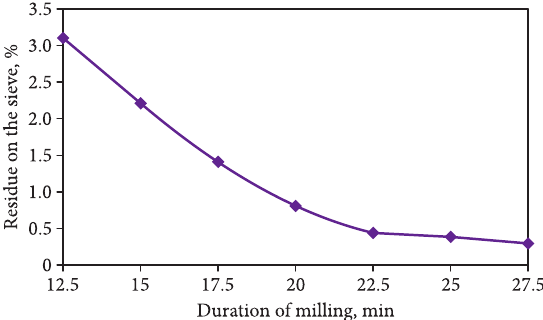
Fig. 3. The dependence of the percentage of residue on sieve of ceramic mass on the duration of